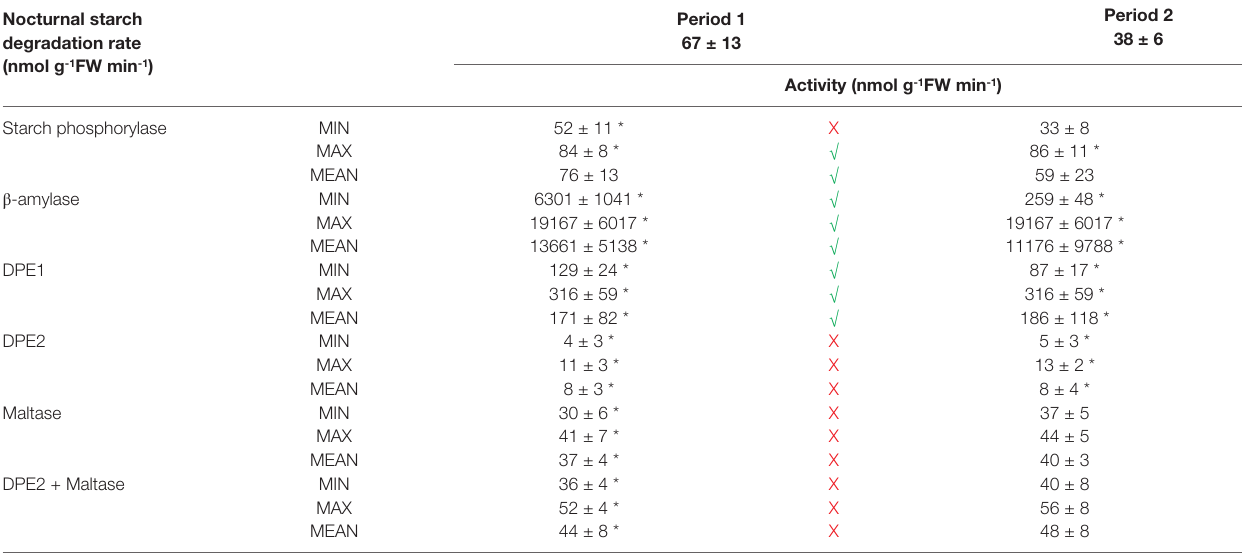
TABlE 1 | Comparison between nocturnal starch degradation rate (nmol g -1 FW min -1 ) and calculated nocturnal activity (minimum, maximum and mean) of starch degradative enzymes (nmol g -1 FW min -1 ) in young fully developed leaves of Phalaenopsis ‘Edessa’, for both nocturnal periods. Nocturnal starch degradation